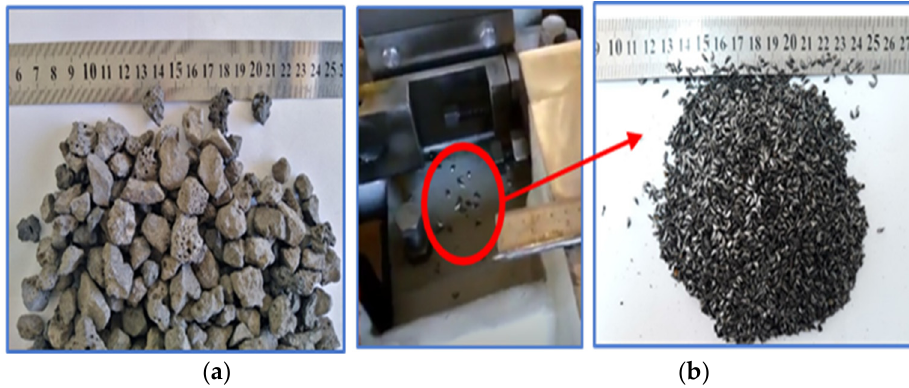
Figure 2. Particle size of fine and coarse aggregates. ( a ) EAFSS. ( b ) MNW.